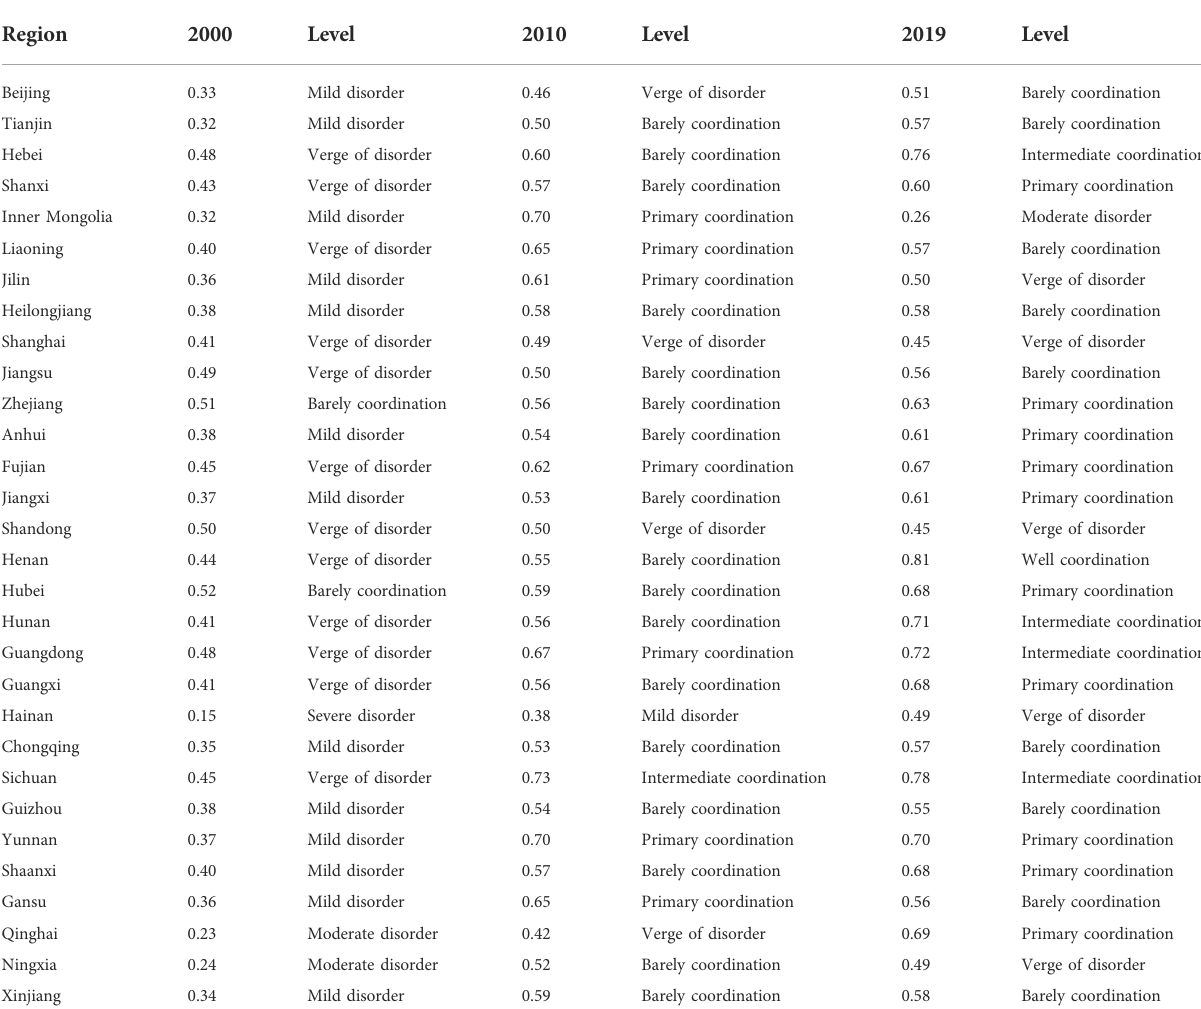
TABLE 3 Results of coupling